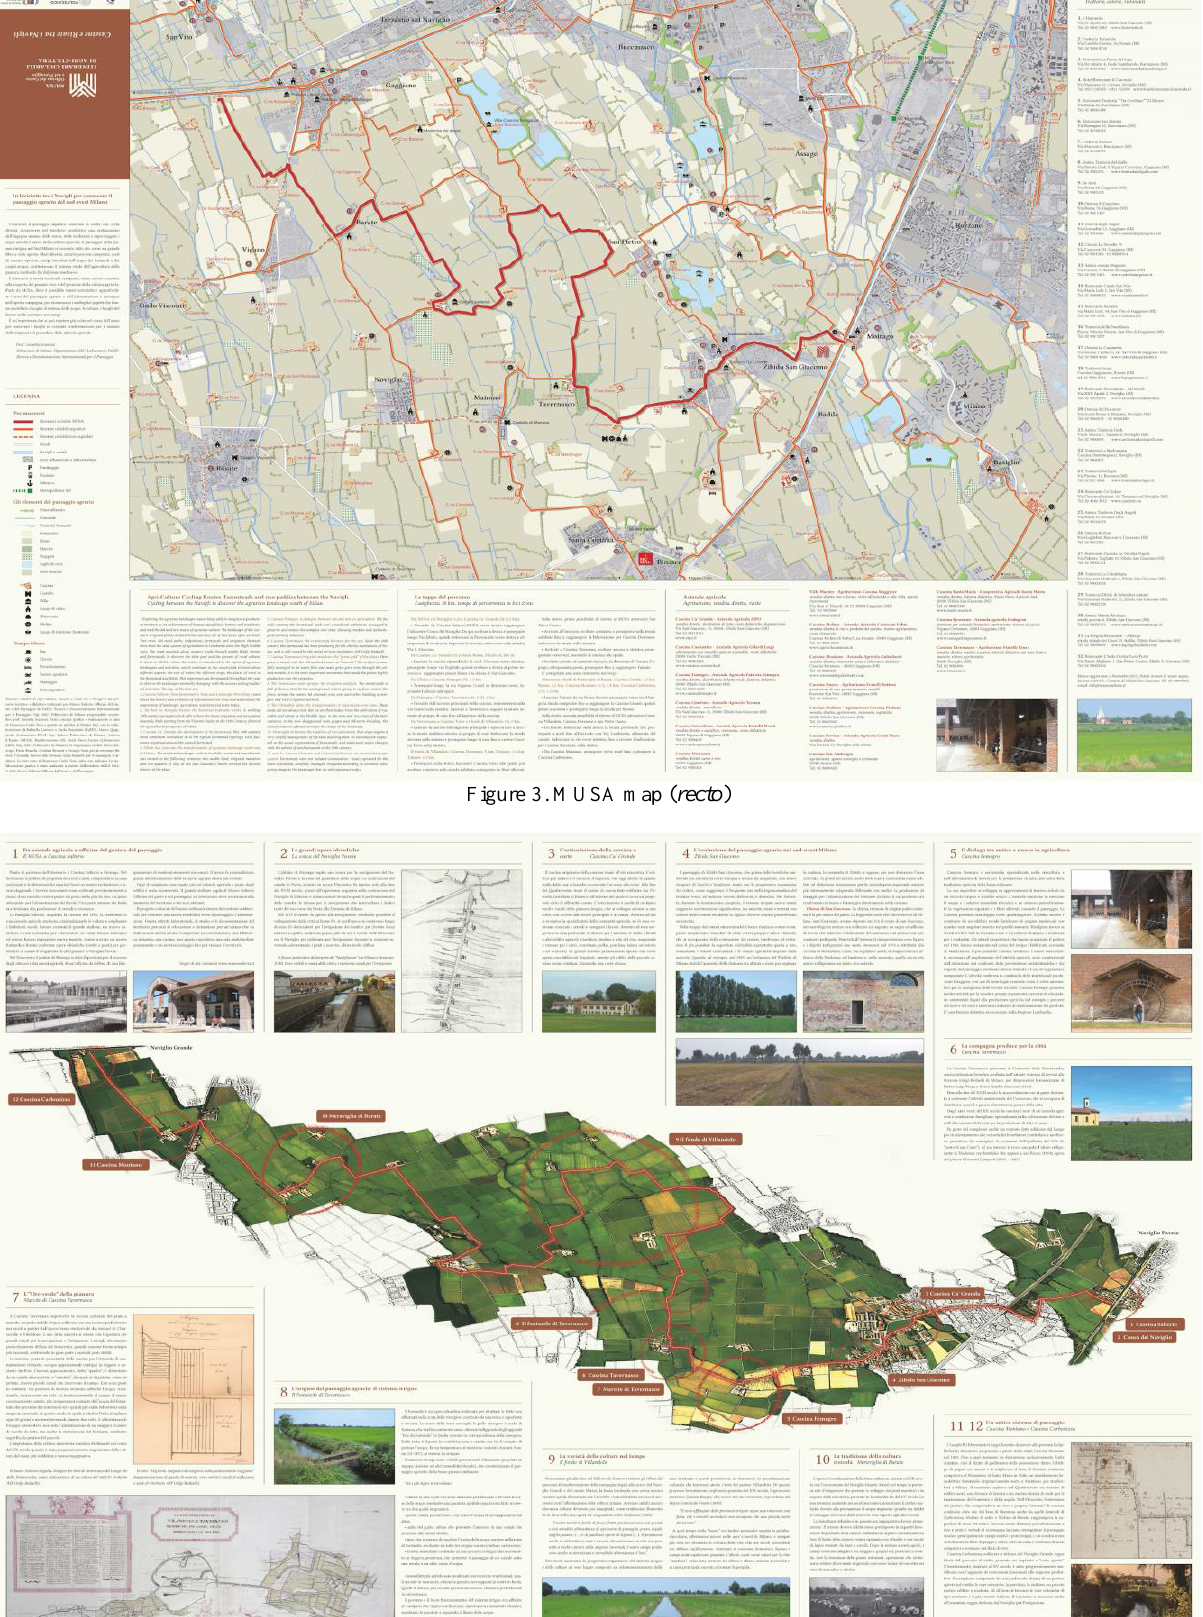
Figure 4. MUSA map ( verso